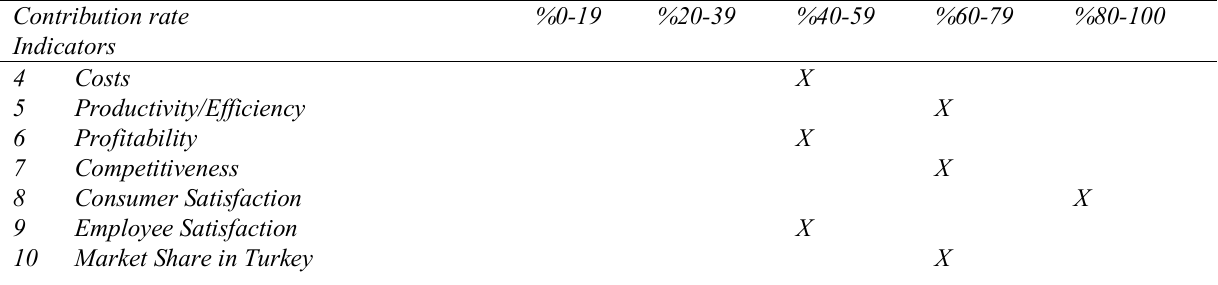
Table 5: A Survey on The Effects And Determinants Of Innovation In White Goods Firm In